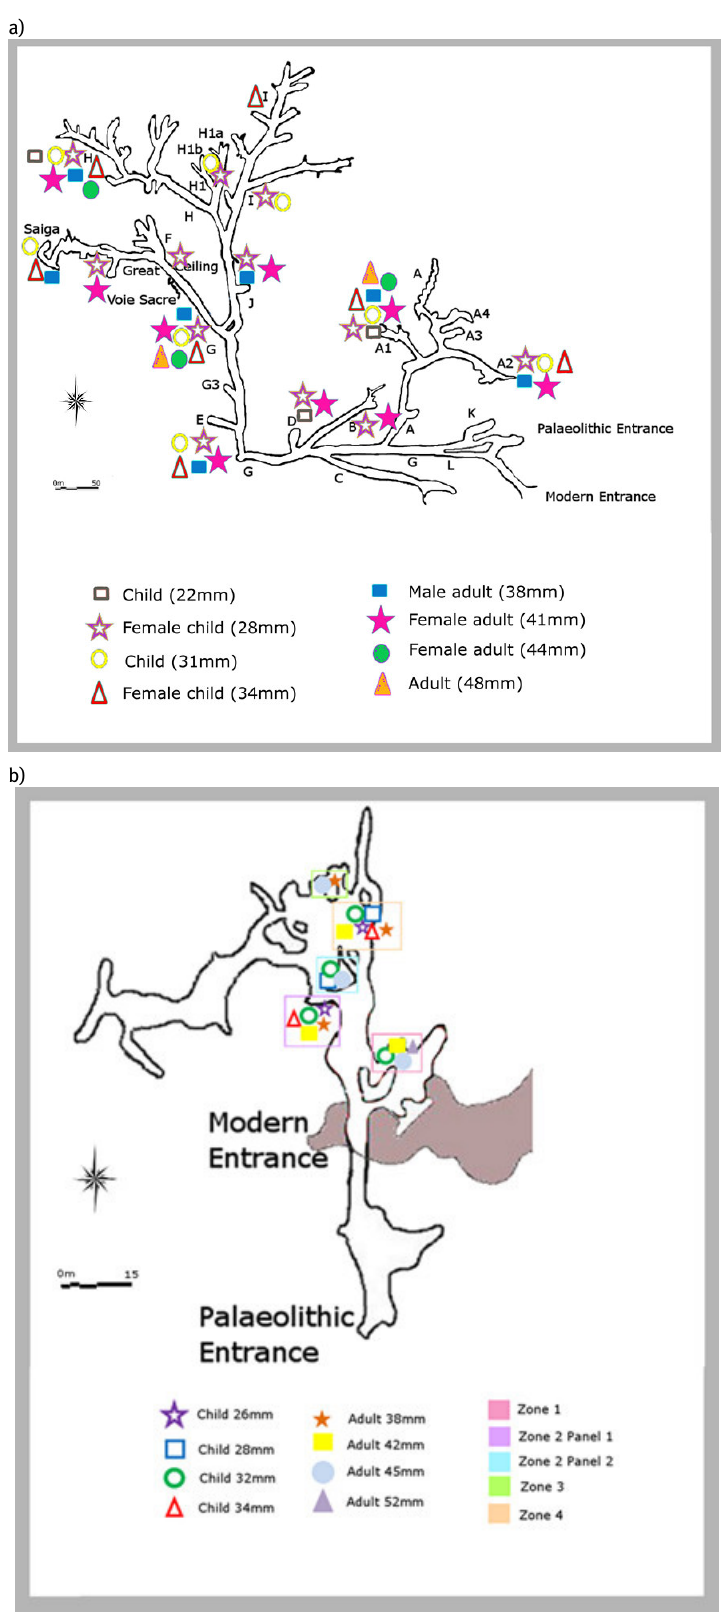
Figure 3. Location of individuals’ flutings in a) Rouffignac and b) Las Chimeneas